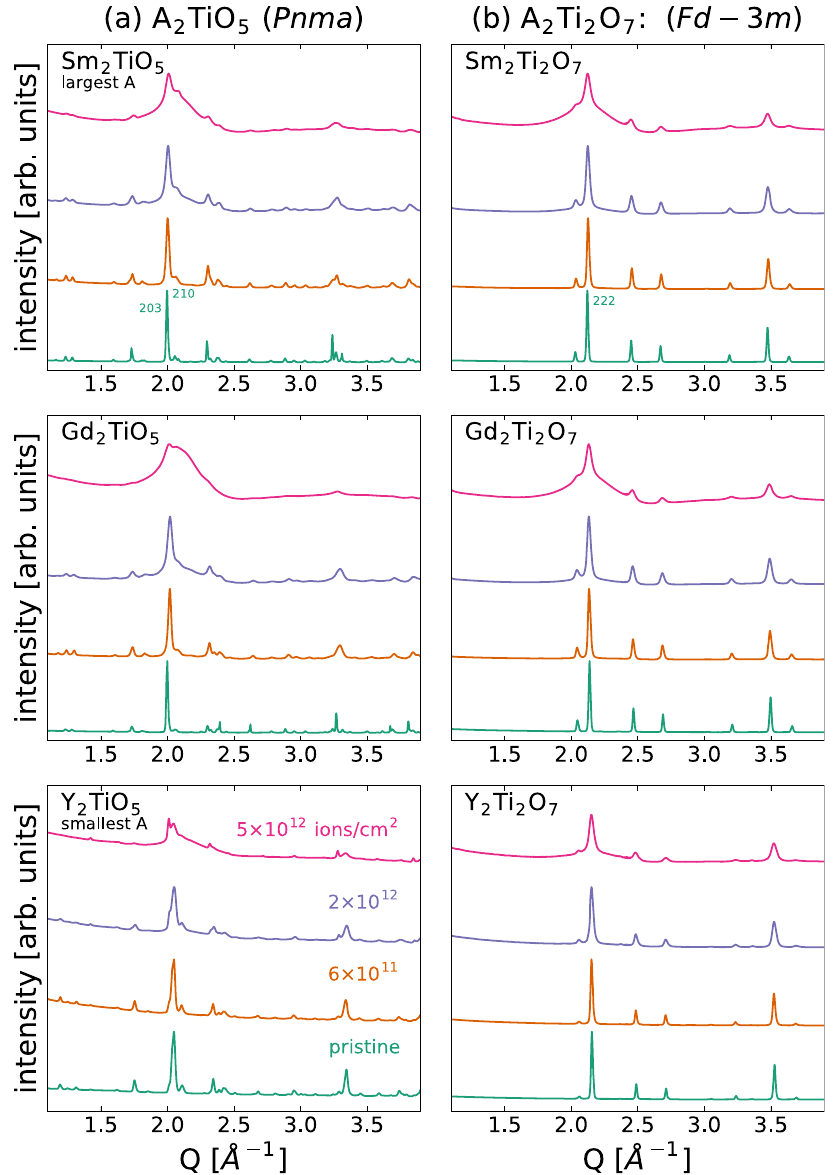
Fig. 3 Synchrotron x-ray diffraction patterns of titanate oxide samples before and after ion irradiation. More pronounced radiation effects are evident in diffraction patterns of a orthorhombic A 2 TiO 5 compared to b cubic A 2 Ti 2 O 7 with A = Sm, Gd, and Y, particularly by the increased diffuse scattering at higher fl uences. Ion fl uences (in ions/cm 2 ) as indicated for Y 2 TiO 5 apply to all sample compositions and irradiation was performed with 2.2 GeV Au ions. Data are from previously published and unpublished work 13,26,27